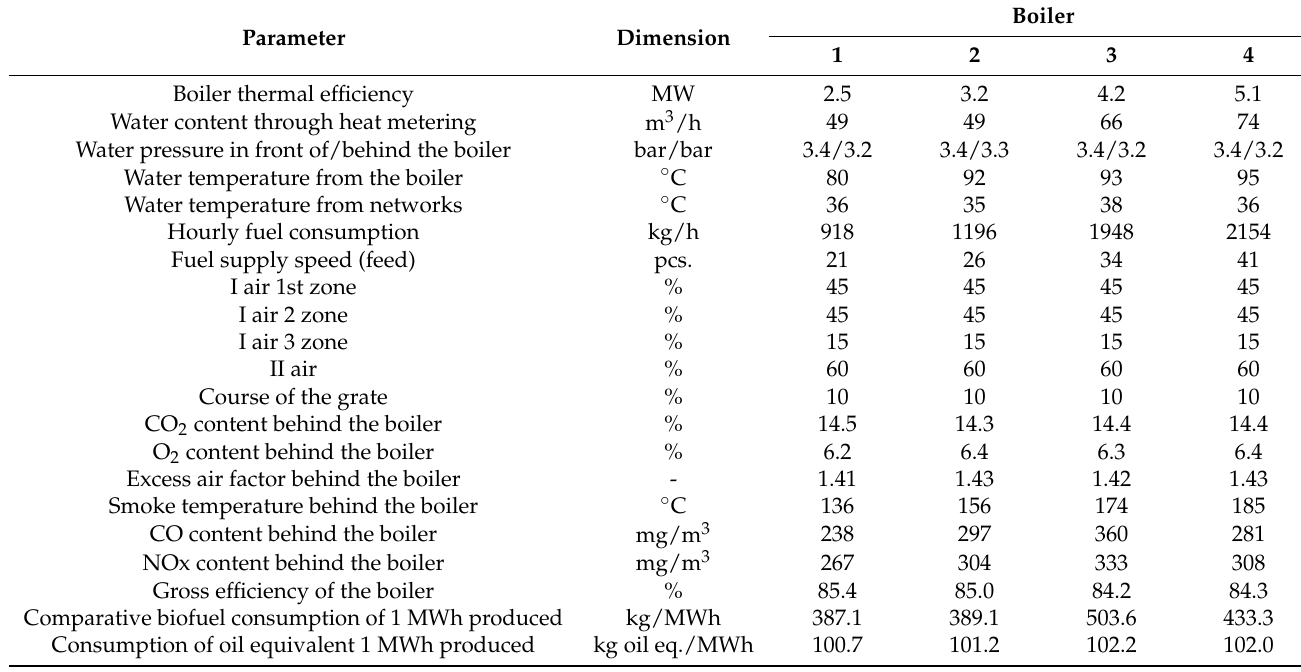
Table 3. Parameters for modes of